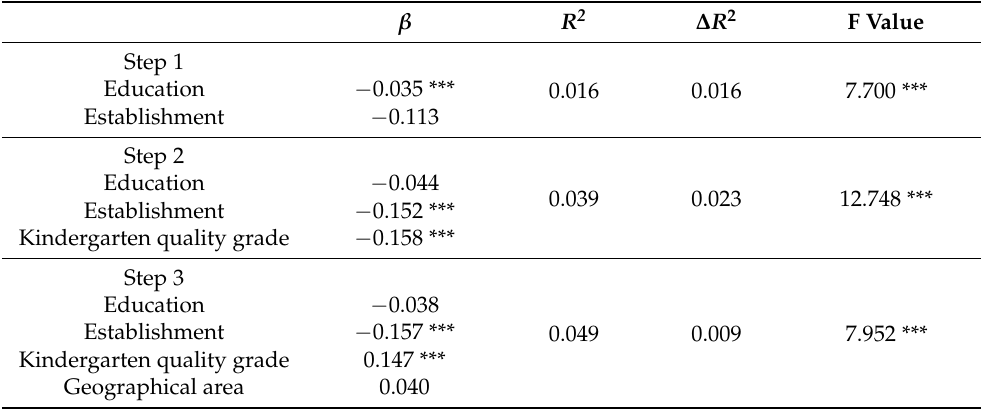
Table 7. Summary of hierarchical regression analyses predicting teacher